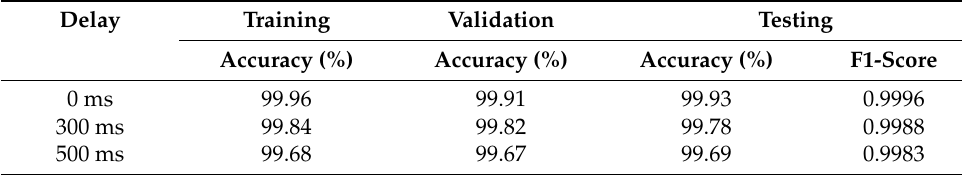
Table 8. Recapitulation of test results for the effect of delayed